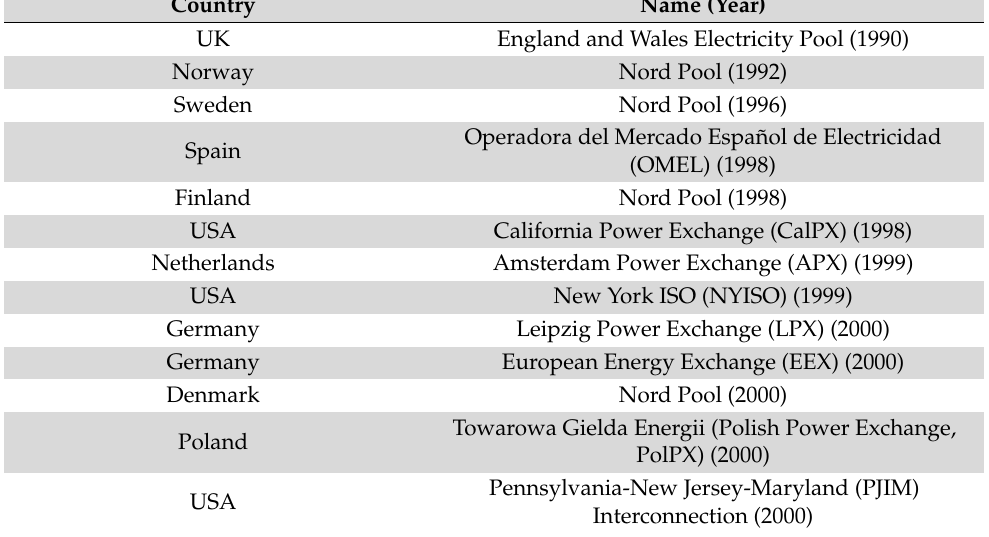
Table 1. Various DAMs in the